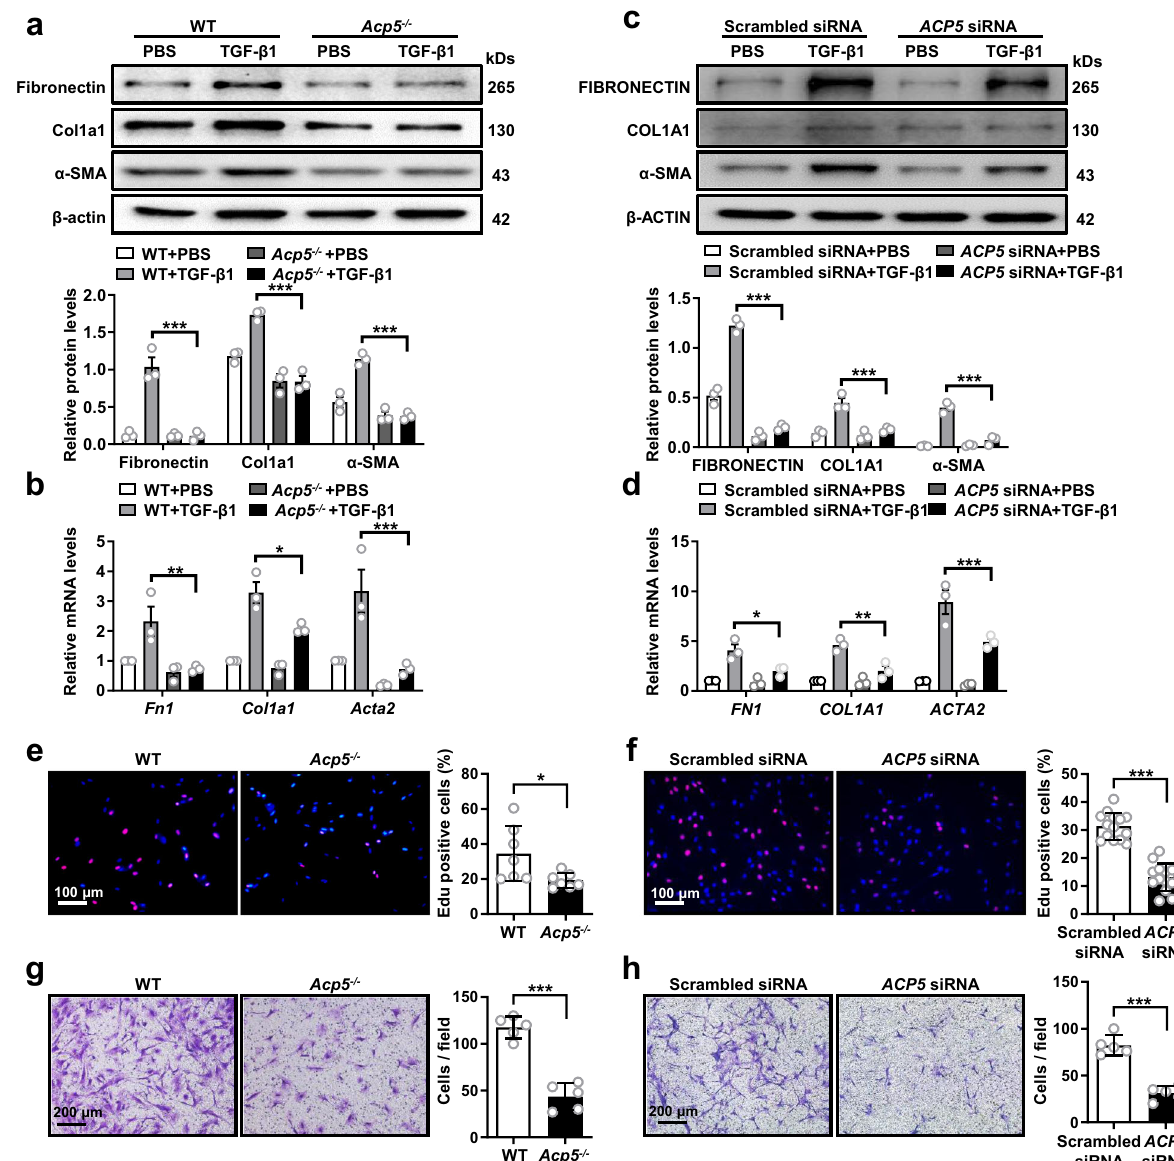
Fig. 3 The impact of ACP5 on the differentiation, proliferation and migration of fi broblasts. a , b Western blot ( a ) and RT-PCR ( b ) analysis of Fibronectin ( a : p < 0.0001, b : p = 0.0038), Col1a1 ( a : p < 0.0001, b : p = 0.0284) and α -SMA ( a : p < 0.0001, b : p < 0.0001) expression in PMLFs from WT or Acp5 − /